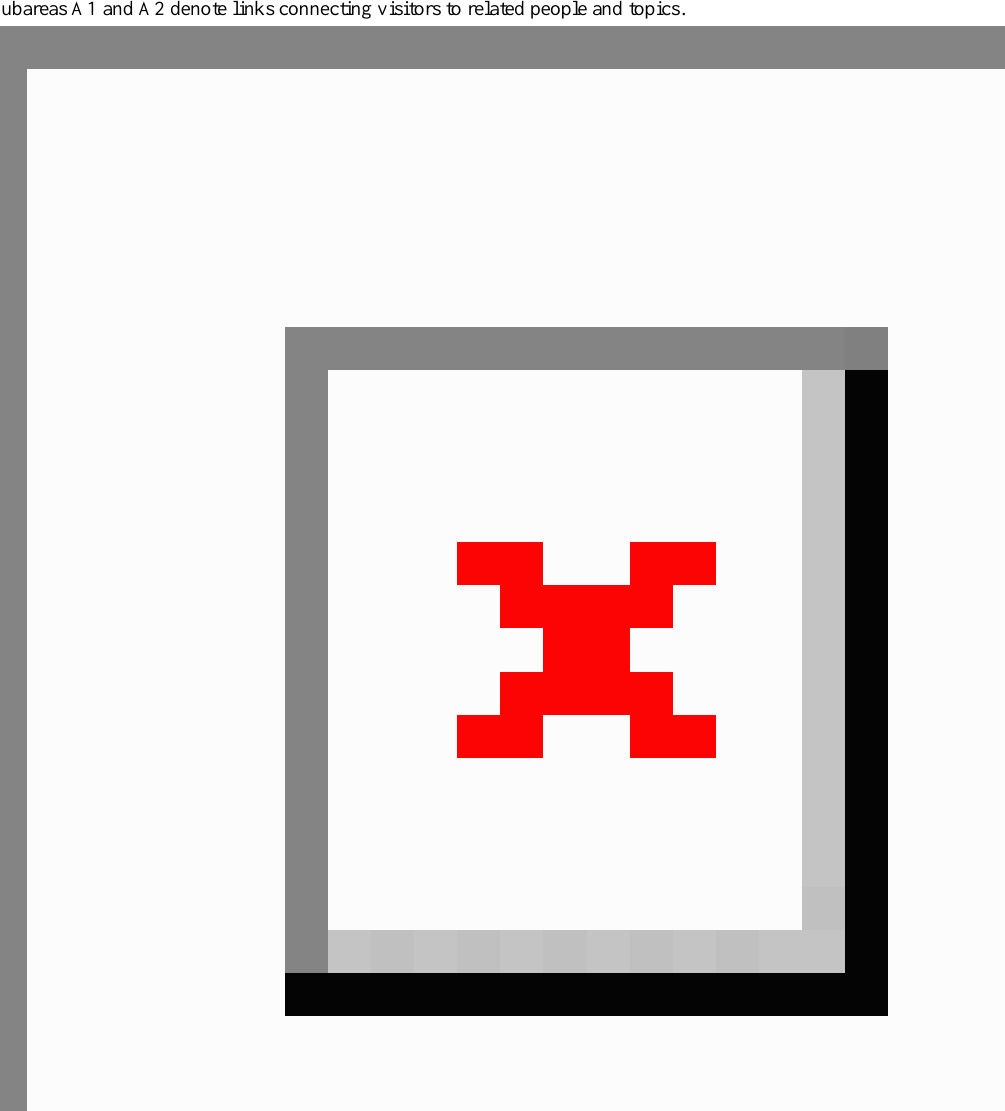
Figure 1. Screenshot of profile in UCSF Profiles. Subareas A, B, C denote 3 sets of links that when clicked through count as an additional page on site. Subareas A1 and A2 denote links connecting visitors to related people and